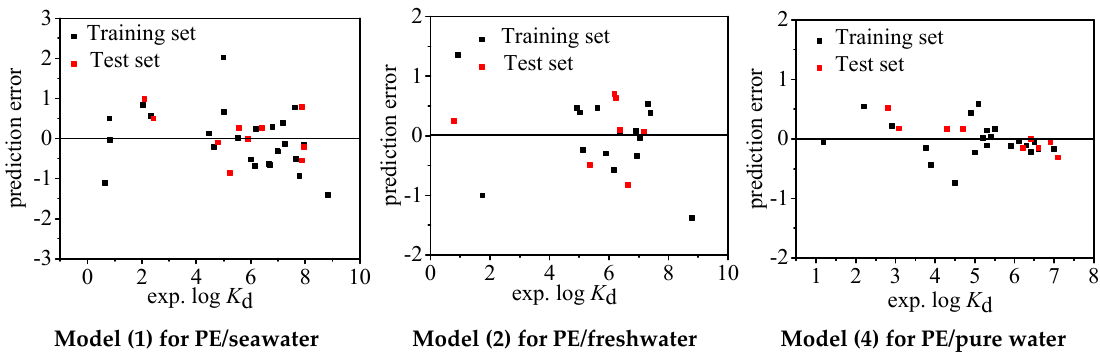
Figure 2. Distributions of prediction errors of log K d calculated by Models (1), (2), and (4). PE, polyethelyne.